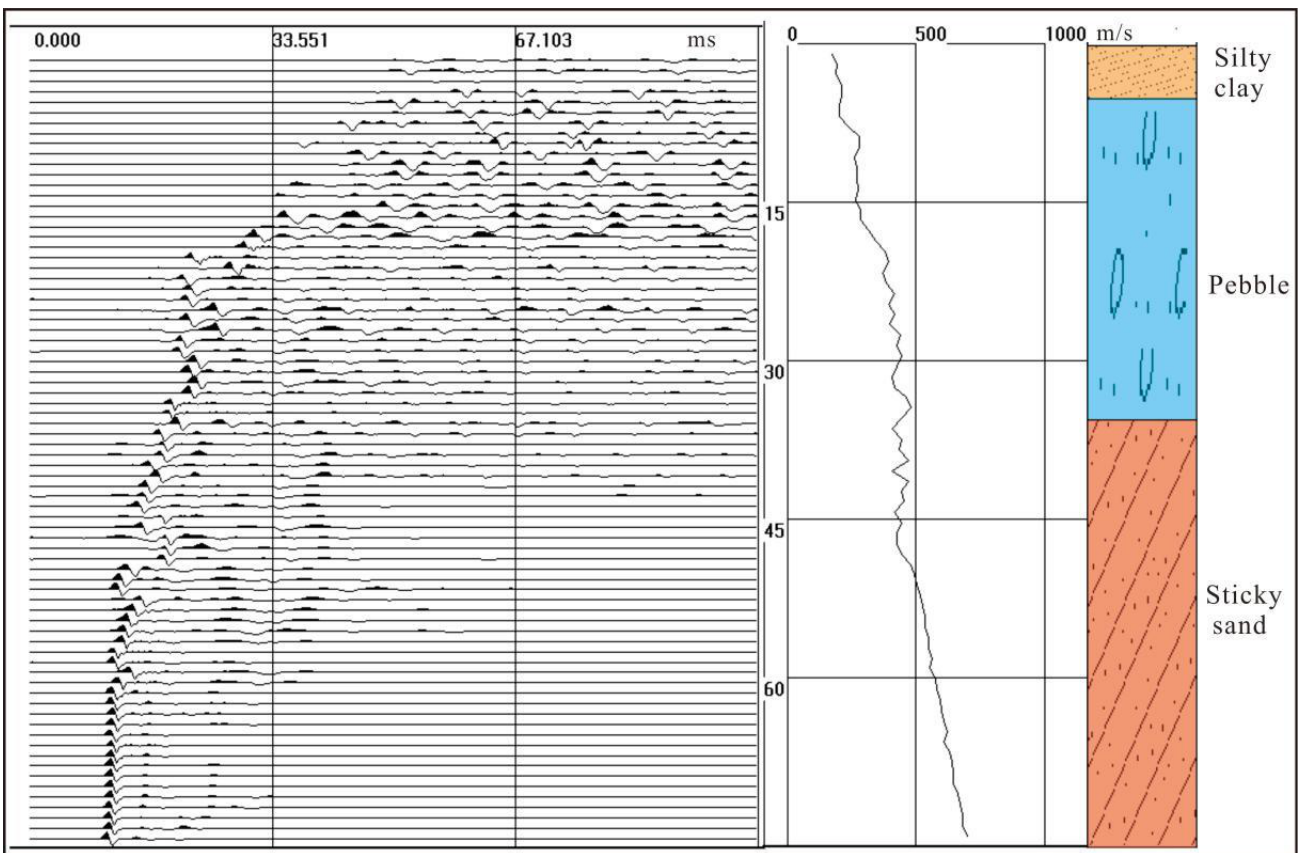
Figure 3. Ground motions under different probabilities.